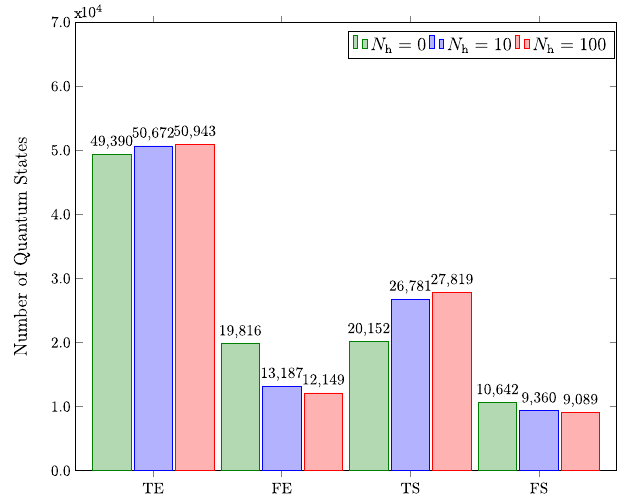
Figure 4. Tripartite quantum states classified as truly entangled (TE), falsely entangled (FE), truly separable (TS), and falsely separable (FS) by testing classifiers with N h = 0 , N h = 10 , and N h = 100 , where N h denotes the number of neurons in the hidden